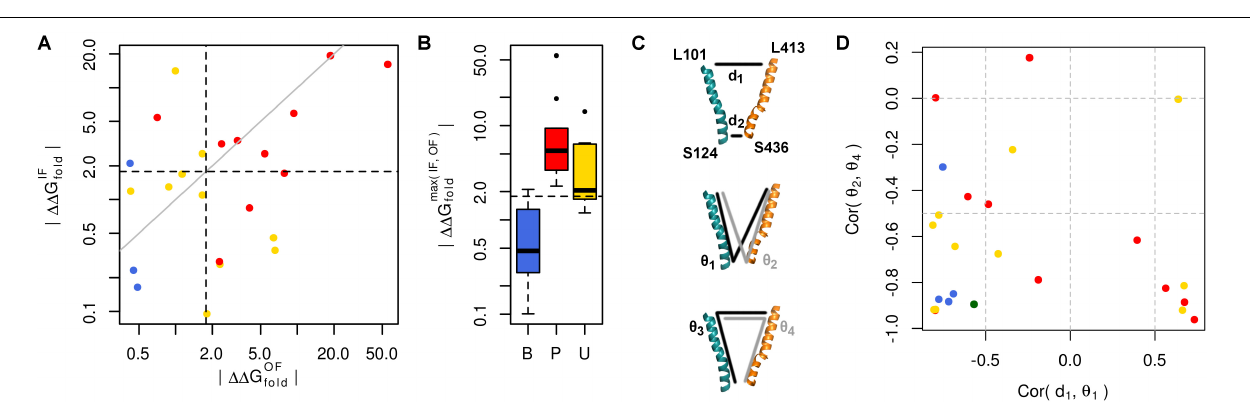
FIGURE 2 | Conservation of inner pore properties. Despite the relatively modest sequence identity across the GLUT family, structural properties, such as the electrostatic distribution around and within the ligand-binding pocket, are conserved. We show our (A) outward-facing and (B) inward-facing GLUT10 models with the binding pocket filled in. In the outward-facing conformation, a large cavity is accessible from the extracellular side, but the inner binding site is fully occluded. A semi-transparent blue surface fills the solvent accessible cavity. Helix 4 (teal) and helix 10 (orange) are colored similar to previous figures. After transitioning to the inward-facing conformation, an opposite relationship is observed. Considering the inward-facing conformation, we split the structure in half according to the two helical bundled described above and color each interior surface by electrostatic potential (red negative, white neutral, and blue positive). Pealing the structure in half reveals that the interior of the pore for (C,D) GLUT10 and (E,F) GLUT1 are highly similar, despite their low sequence conservation (24%) and that GLUT1 was not used in the MSA for constructing our GLUT10 model (Supplementary Table S2). Horizontal lines and positive (+) or negative (–) annotation indicate regions where electrostatics switch consistently between GLUT1 and GLUT10. (G) Pathogenic variants tend to alter charge segregation of the channel lining. We first selected residue positions that make up the channel interior lining in either conformation. Each variant’s change to the electrostatic character of the channel interior was quantified using a simple pI-based score; see the section “Materials and Methods” section. A gray line marks the maximum change possible among uncharged amino acids.